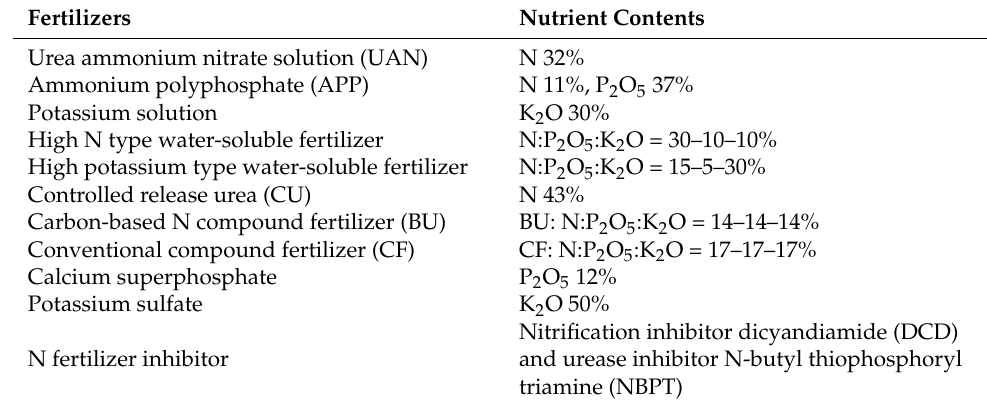
Table 1. Nutrient contents of fertilizers used in the